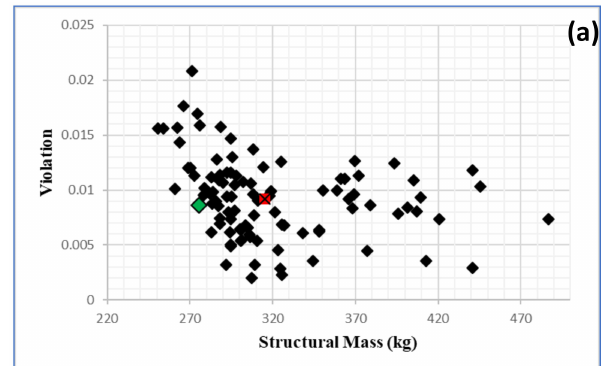
Figure 16. Conts